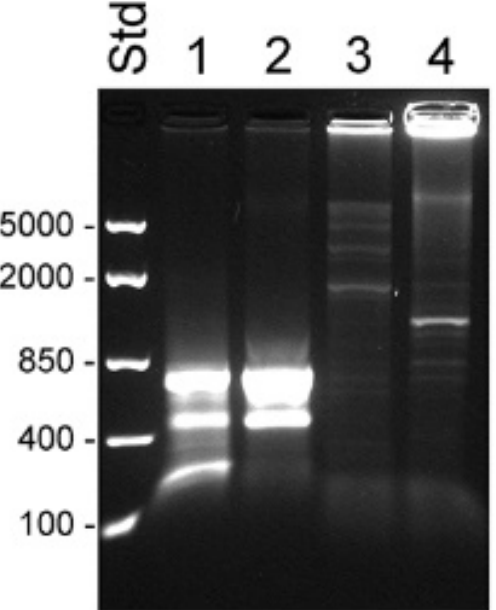
Figure 5. Transcripts detected by 5′ RACE PCR in RNA from prostate cancer bone metastasis. RACE products were separated on a 1.2% agarose gel. The 5′ RACE cDNA was synthesized using pooled total RNA prepared from bone metastasis of patients suffering from castration-resistant (lanes 1 and 3, n = 5) or hormone-naïve (lanes 2 and 4, n = 2) prostate cancer. PCR was run using KLK4-specific oligo KLK4r18 (lanes 1 and 2) or KLK4T2-specific oligo KLKP9R (lanes 3 and 4) in combination with the UPM primer from the RACE kit. RNA was prepared using AllPrep DNA/RNA/Protein kit (Qiagen). FastRuler Middle Range (Std) was used as molecular weight standard, and relevant sizes in bp are indicated in the figure to the left.